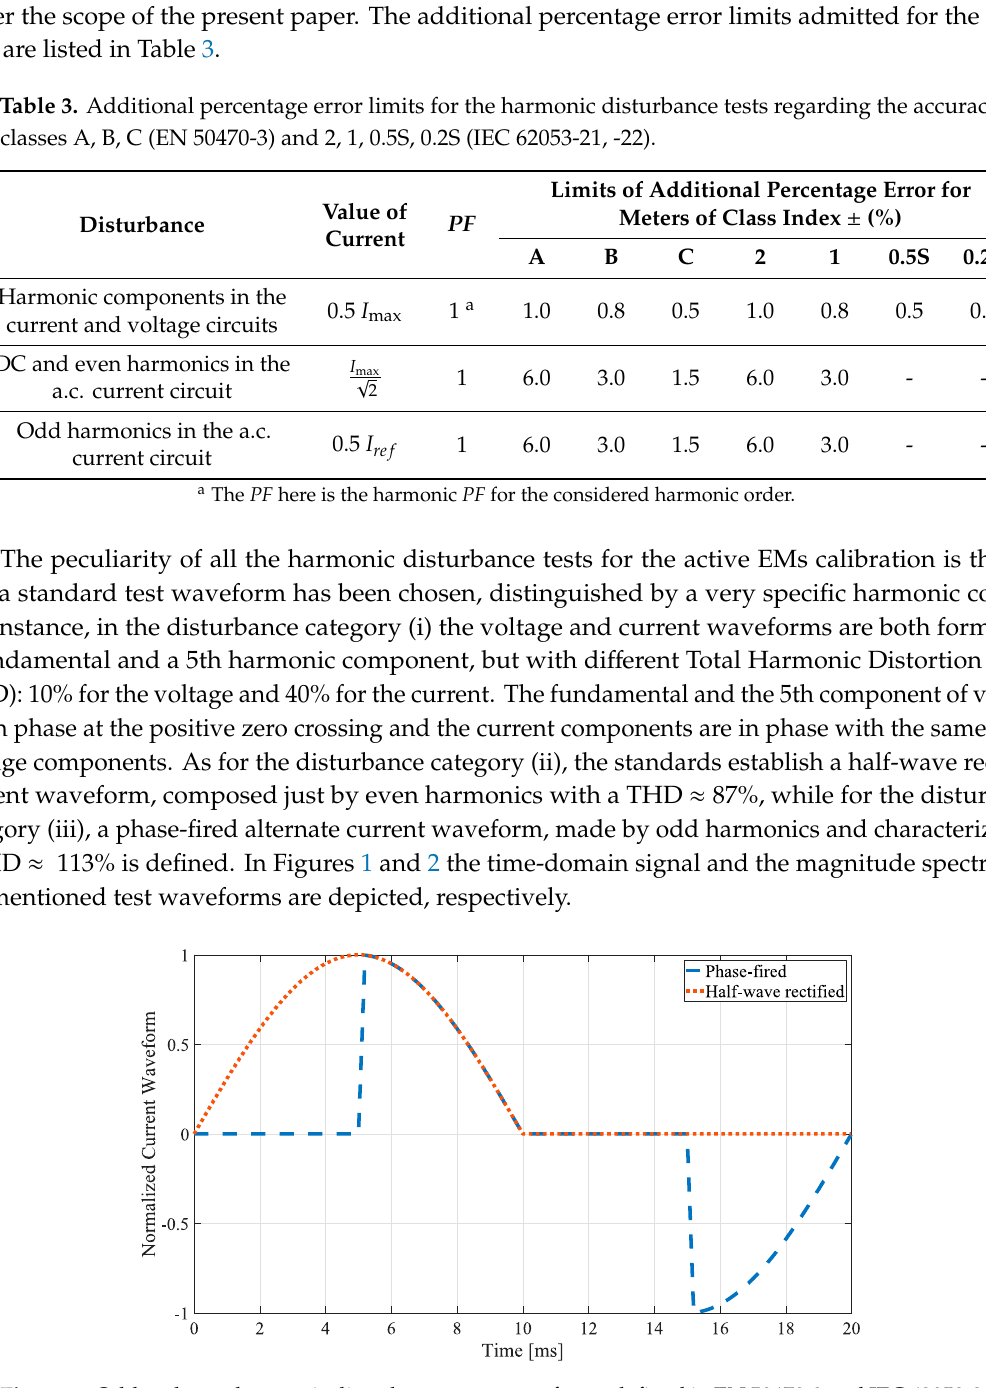
Figure 1. Odd and even harmonic disturbance tests waveforms defined in EN 50470-3 and IEC 62053- 21.